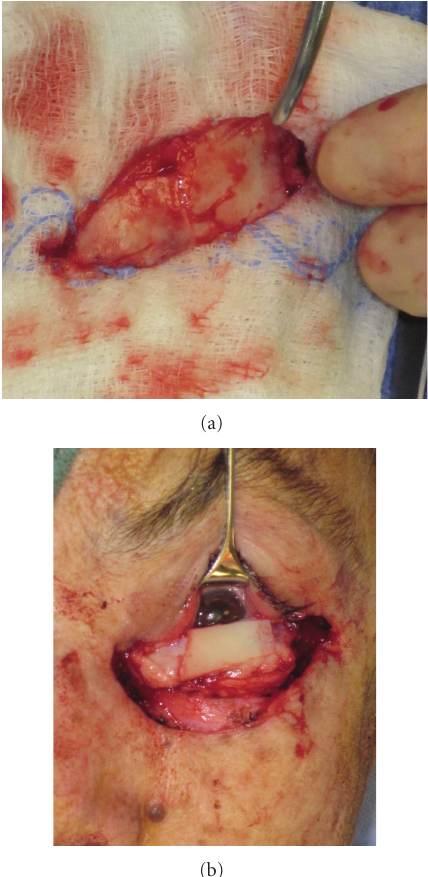
Figure 2: A 2 × 5cm nasal septal cartilage graft was harvested from the left septum (a). The graft was placed into the defect as a tarsus with the mucosa facing the eyelid